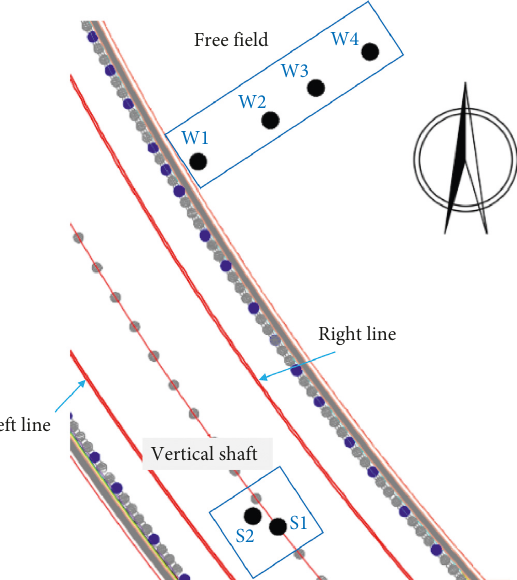
Figure 1: Measuring points of construction site.